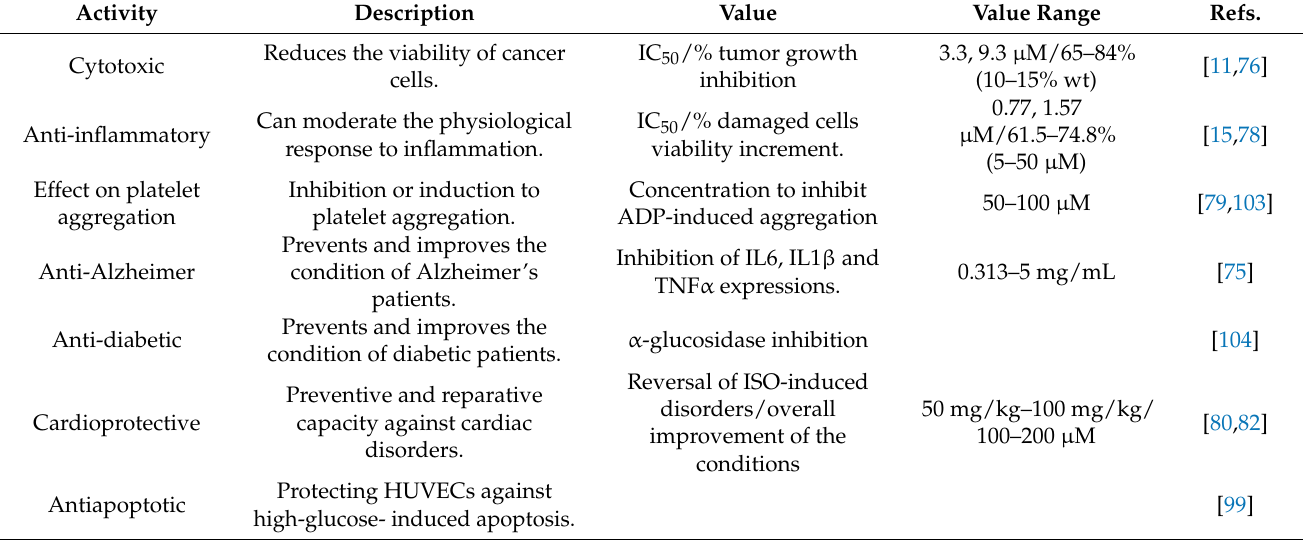
Table 8. Timosaponin BII ( 50 )